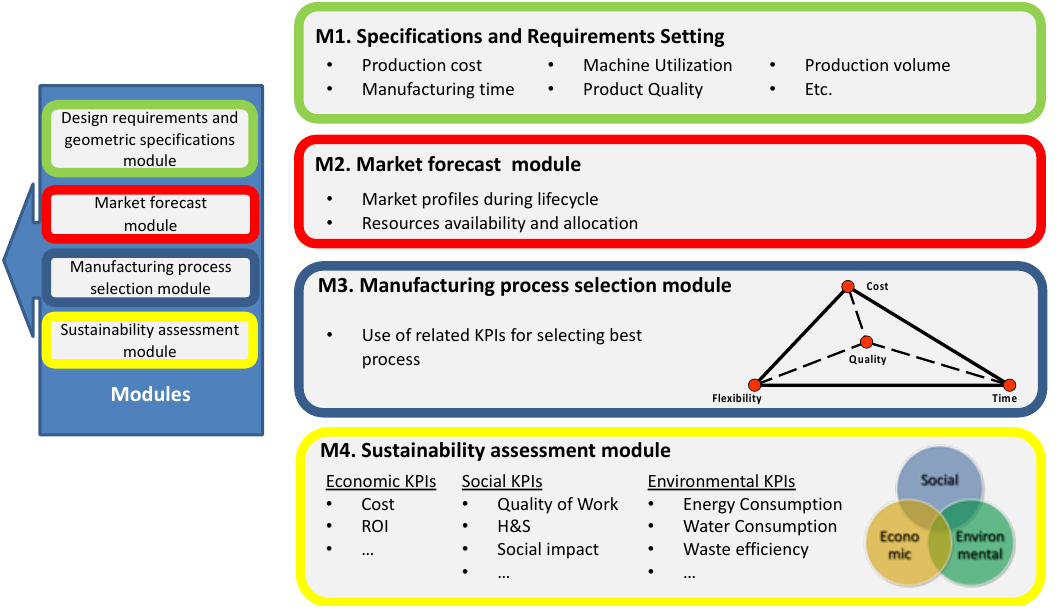
Figure 7. Module details.